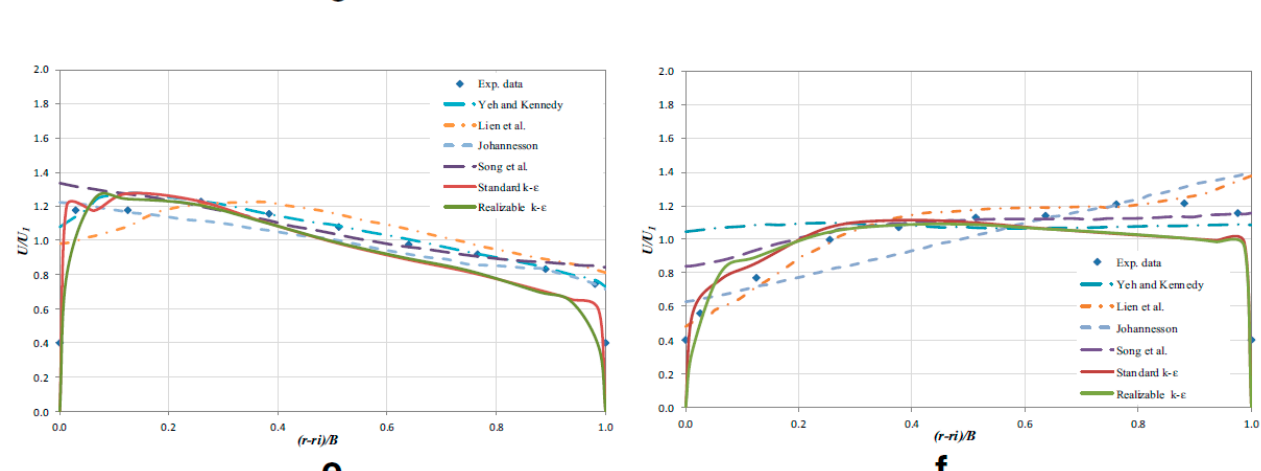
Figure 11. A comparison of resultant velocities across dimensionless channel width for the Rozovskii channel [2]. ( a ) at θ = 0°; ( b ) at θ = 35°; ( c ) at θ = 65°; ( d ) at θ = 100°; ( e ) at θ = 143°; and ( f ) at θ = 186° (Shaheed et al., 2018) [55].